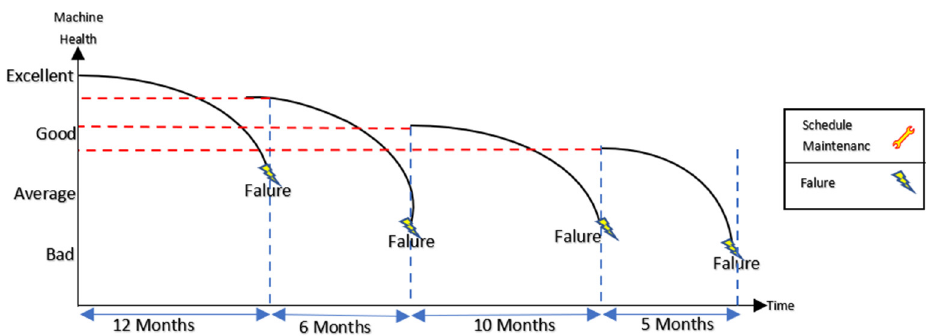
Figure 2. Repair and maintenance strategy using the corrective maintenance